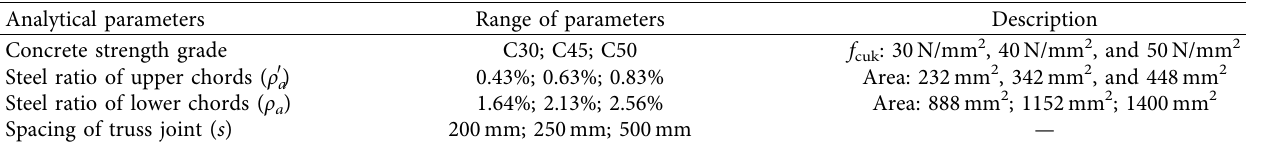
Figure 7: Vertical load-strain curve of steel tube. (a) B-1. (b) B-2. (c) B-3. (d) B-4. (e) B-5. Table 2: Parameters of FEA